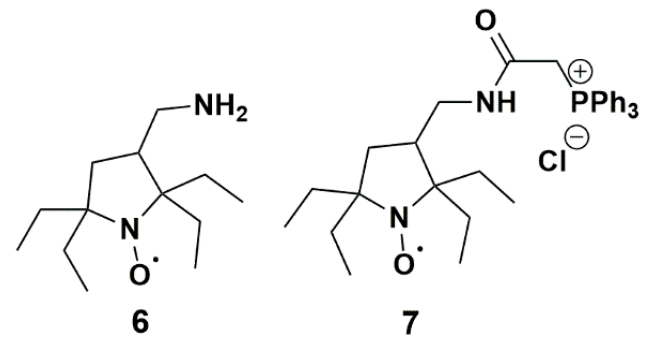
Figure 12. Pyrrolidine nitroxides tested by Kirilyuk et al.; ( 6 ) 3-(aminomethyl)-2,2,5,5-tetraethylpyrrolidineyloxyl; ( 7 ) 3-(2-triphenylphosphonio)acetamidomethyl-2,2,5,5-tetraethylpyrrolidine-1-oxyl chloride.